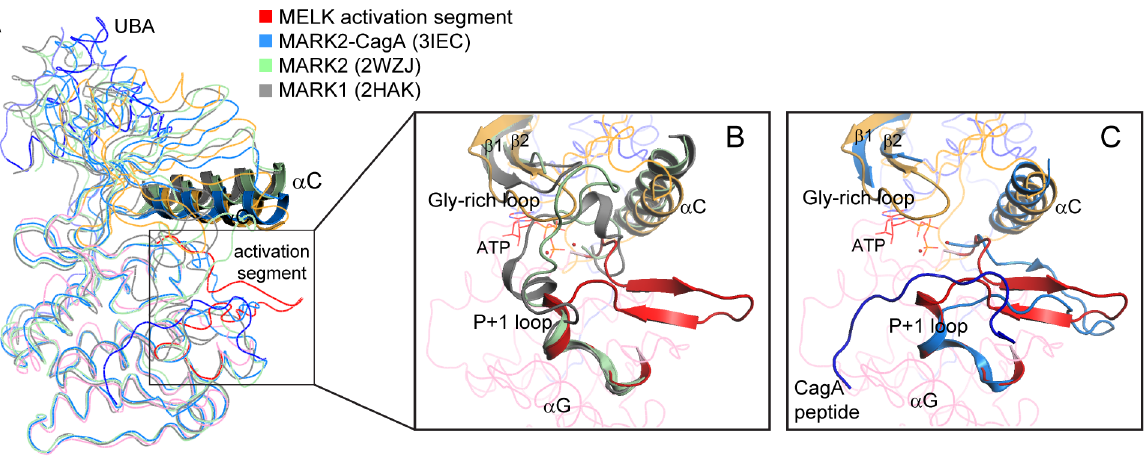
Figure 5. Conformational differences between the activation segments in MELK and MARK KD-UBA structures. (A) Superposition of four KD-UBA structures with ordered activation segments. The MELK KD-UBA structure is colored as in Figure 2A, the MARK2-CagA complex (3IEC) in marine blue, the double mutant MARK2 (2WZJ) in light green, and the wildtype MARK1 (2HAK) in gray. For clarity, only the a C helices are depicted in cartoon. (B) Close-up view of the activation segments of MELK, MARK2 (2WZJ) and MARK1 (2HAK). The molecules are colored as in panel A. For clarity, the activation segment, helix a C and Gly-rich loop in MELK are highlighted, and only these elements in MARK1 and 2 are shown. The ATP molecule adapted from PKA (1ATP) is shown as red lines. (C) Close-up view of the activation segments of MELK and the MARK2-CagA complex (3IEC). For the MARK2-CagA complex, only the activation segment, helix a C, Gly-rich loop and the CagA peptide (blue) are shown.